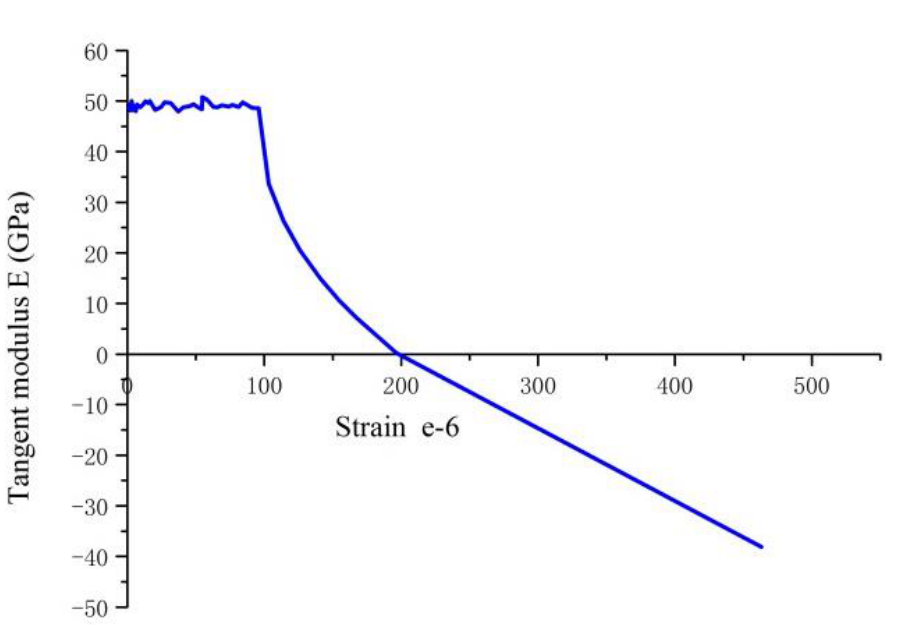
Figure 7. Axial tension strains, tangent elastic modulus curve of RPC.